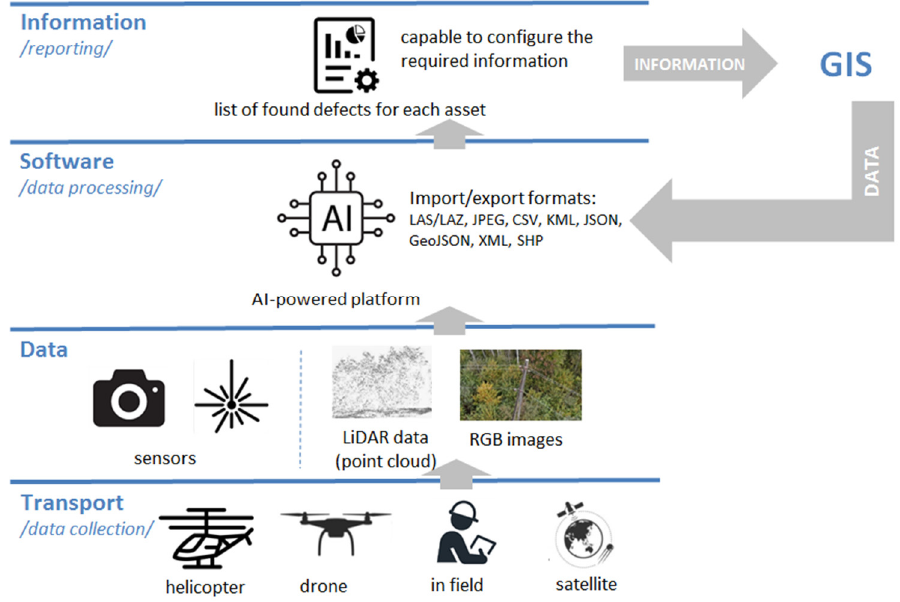
Figure 27. Scheme to turn collected data into information (on defects).